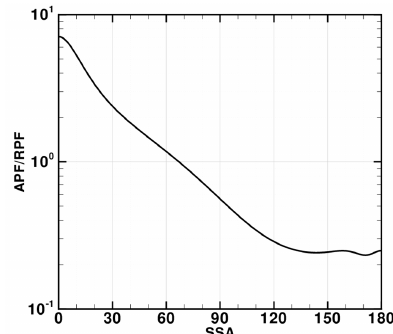
Figure 15. The ratio of APF (or P a ) to RPF (or P R ) as a function of SSA (or (cid:50) ) for the V1 OMPS LP aerosol size distribution. This ratio declines by a factor of ≈ 50 between forward ( (cid:50) = 0 ◦ ) and backward ( (cid:50) = 180 ◦ ) scattering conditions.